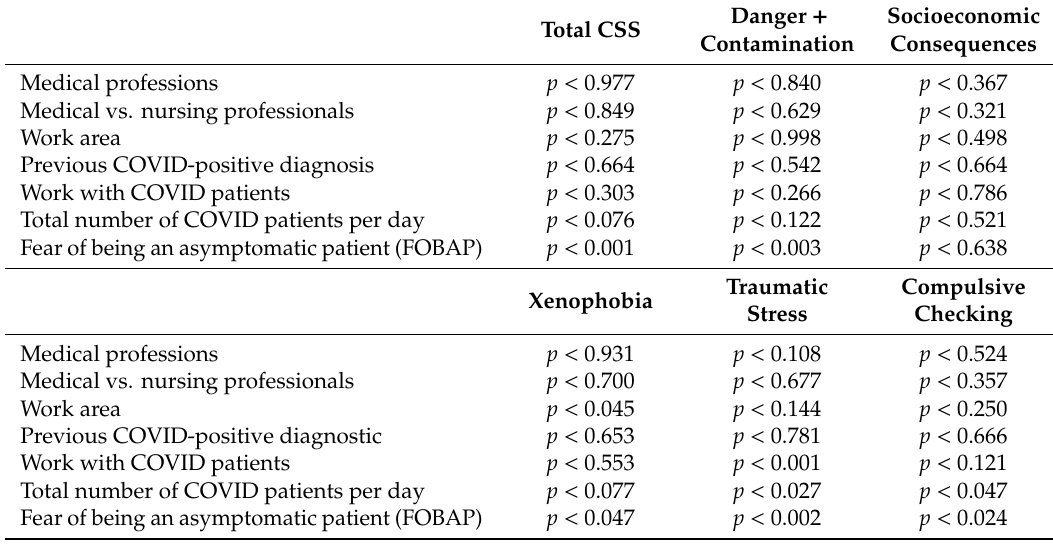
Table 3. Overview of all resulting Pearson´s chi-square for all tested